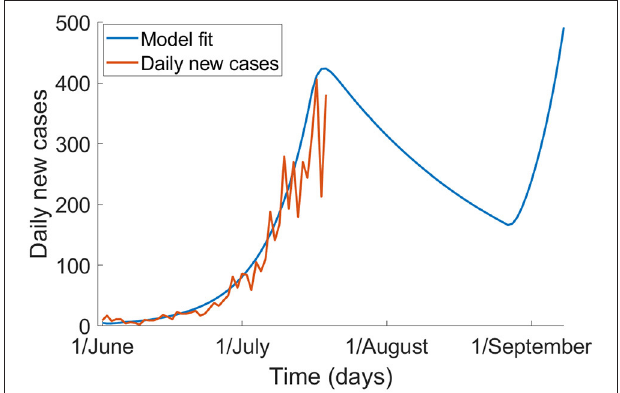
FIGURE 1 | The epidemic of COVID-19 in Victoria without mask use, and with a 6-week lockdown from 9 July to 20 August (blue) and the observed epidemic up to 19 July 2020 based on notification data (red).